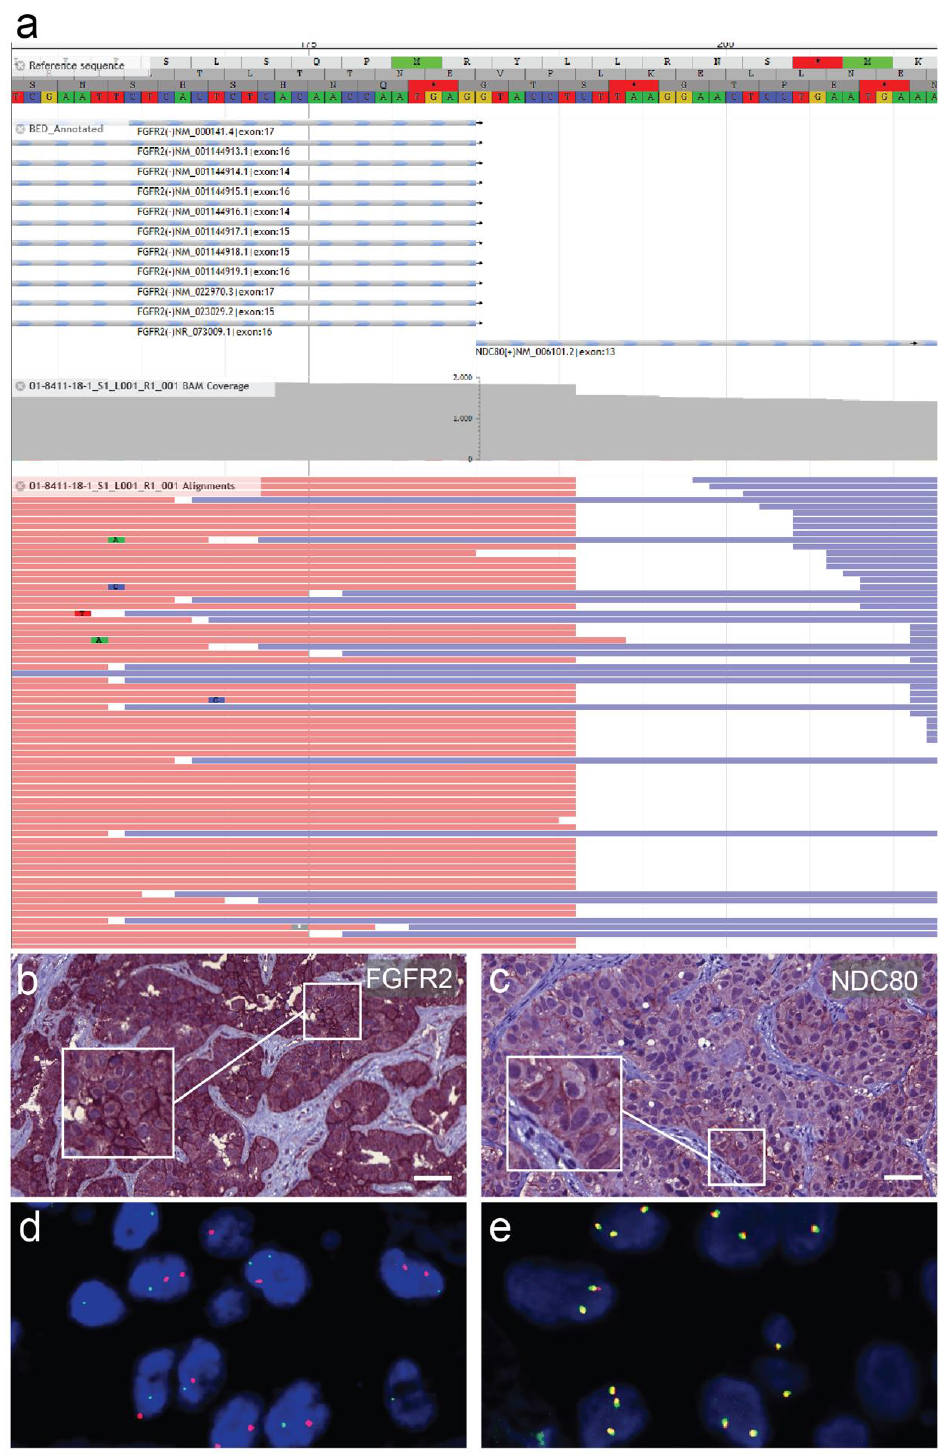
Figure 2. Detection and characterization of the fusion protein. ( a ) Schematic representation of the Fibroblast growth factor receptor 2 (FGFR2)-NDC80 kinetochore complex component (NDC80) fusion of the patient displaying reads and covered sequence. ( b ) Immunostaining for FGFR2 of a primary liver tumor biopsy specimen showing pronounced membranous expression. ( c ) Immunostaining for NDC80 of the nodal metastasis with focally accentuated ectopic membranous expression pattern. Scale bars = 50 µm. ( d ) FGFR2 fluorescence in situ hybridization break-apart signal with atypical distribution pattern in lymph node metastasis of the presented patient. ( e ) Physiologically fused signals in a different cholangiocarcinoma patient for